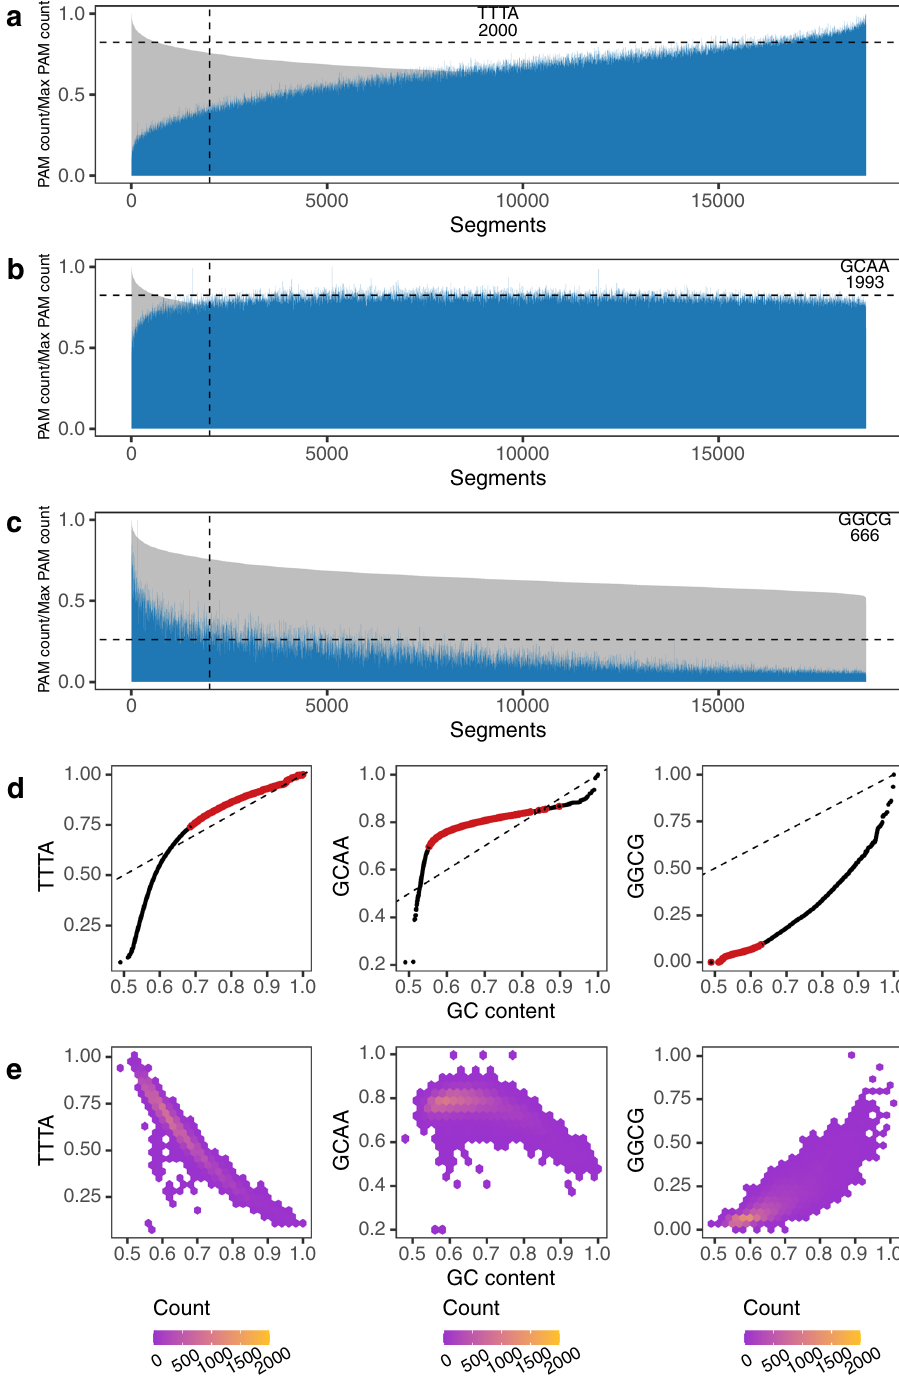
Fig. 2 TTTA, GCAA, and GGCG enriched regions compared with GC-rich regions. a – c TTTA, GCAA, and GGCG content of 18,763 segments (excluding 1237 segments with all-N bases), respectively. The genome segments are ordered by decreasing GC content (gray), and the corresponding PAM content is plotted in the same order (blue). The segments left to the vertical dashed line are the top 2000 segments for GC content, and the segments above the horizontal dashed line are the top 2000 segments for the TTTA, GCAA, and GGCG PAM, respectively. The number in the plot shows the number out of the top 2000 PAM segments that are not in the top 2000 GC-rich segments. d Quantile – quantile plot of the segments GC content v.s. PAM content distributions, where the red circles show the top 2000 PAM segments, and the dashed line represents y = x . e Hexbin plot of segments GC v.s. PAM content, where the color represents the count of points in each hexagon. GC and PAM content is normalized to the 0 – 1